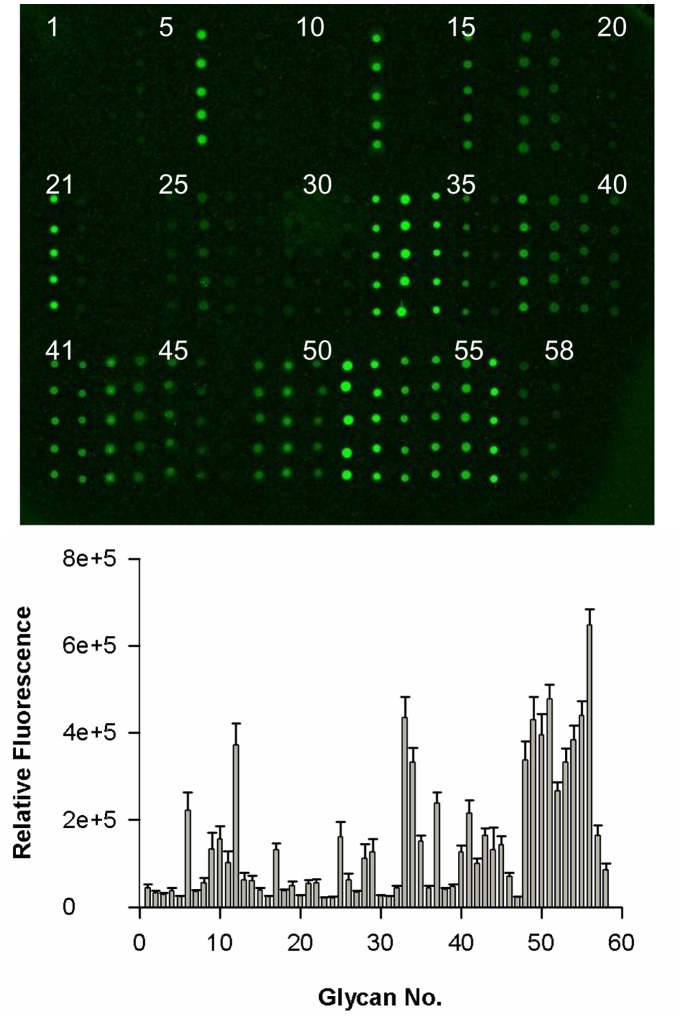
Detection of antibodies to 58 carbohydrate antigens in serum from patients with HCC.(A) A representative slide image obtained from a fluorescence scan after detection of IgG in serum samples. Each grid was printed with glycan numbers 1–20 in the top row, 21–40 in the middle row, and 41–58 in the bottom row. (B) Mean ± standard deviation binding specificity of antibodies to glycan numbers 1–58 in serum samples from patients with HCC. Relative fluorescence intensities were calculated for each spot (containing 100 µM glycan) in the glycan microarray.